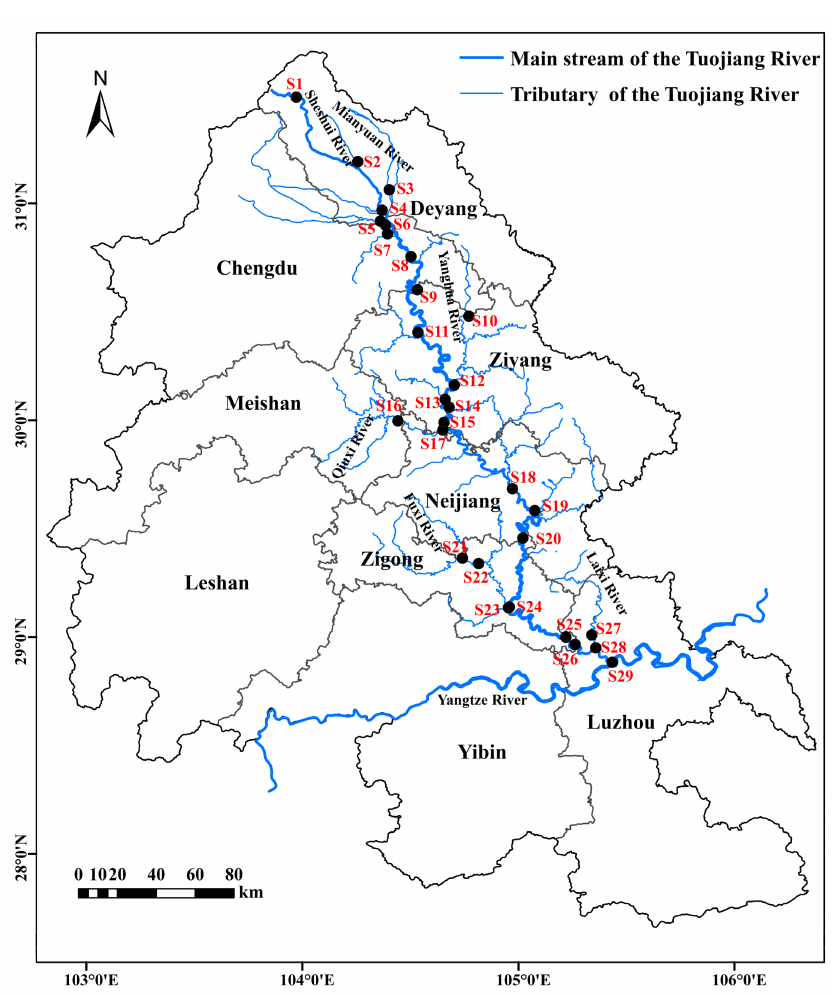
Figure 1. Locations of the 29 water and sediment sampling stations (S1–S29) in the Tuojiang